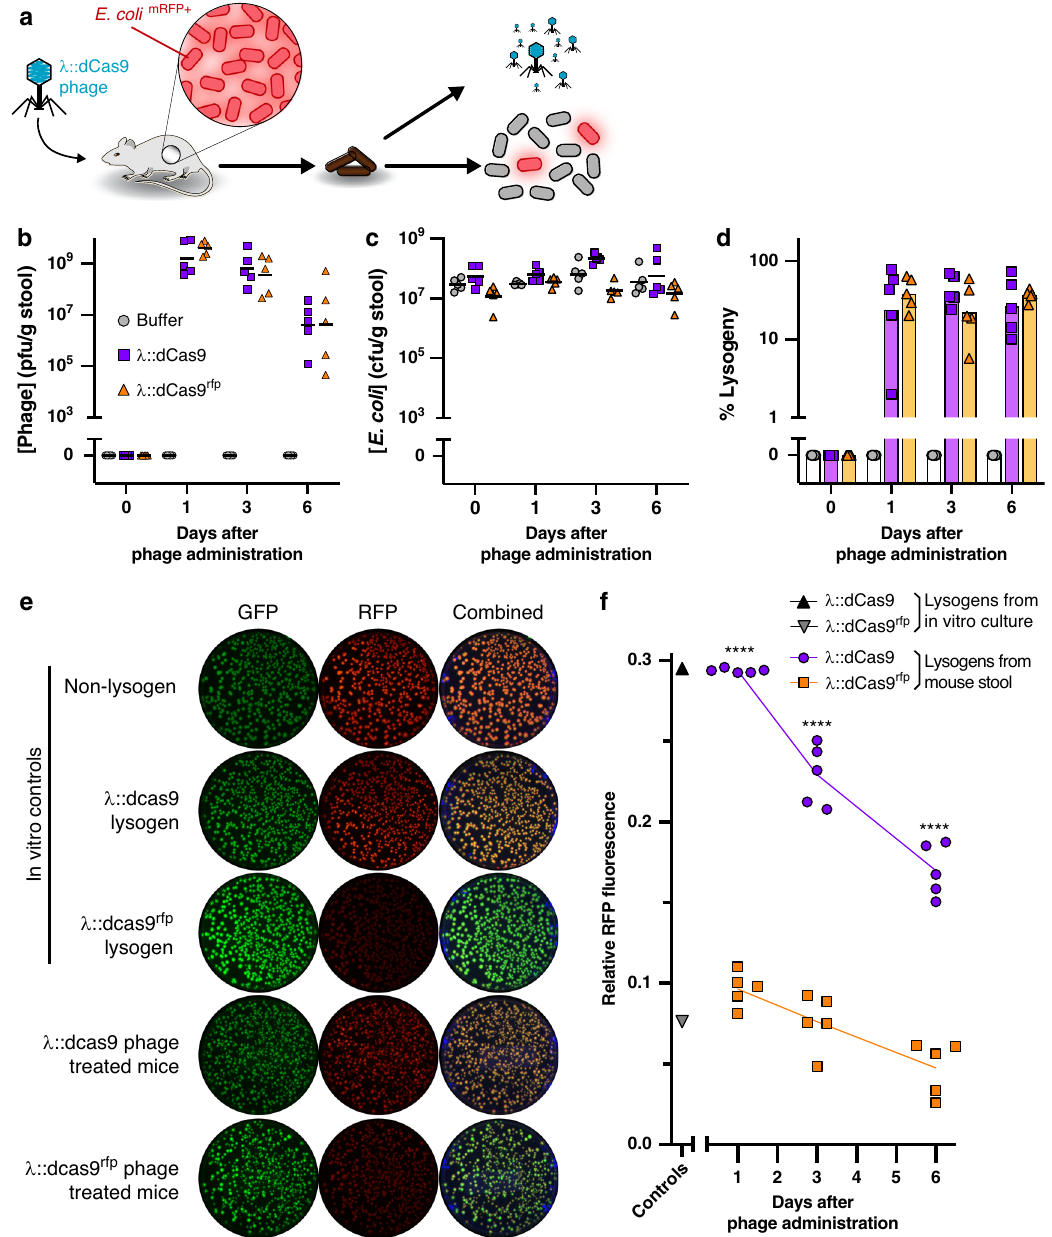
Fig. 3 Phage delivered genetic repression in vivo. Engineered phage or vehicle was orally administered in bicarbonate solution to mice pre-colonized with E. coli expressing RFP and GFP ( a ). After oral administration, fecal phage ( b ), total E. coli ( c ), and percentage of E. coli lysogenized by phage were quanti fi ed ( d ). Representative fl uorescence images of colonies of fecal lysogens are shown compared to in vitro-cultured controls, reproducible across three time points for each of fi ve mice ( e ). Relative RFP intensity normalized by GFP intensity of fecal lysogens from mice. Positive and negative controls represent in vitro-cultured λ ::dCas9 rfp and λ ::dCas9 lysogens, respectively ( f ). Symbols represent individual mice ( n = 5) with bars or lines indicating the geometric mean. Signi fi cance was calculated for preselected time-matched samples using one-way ANOVA with a Sidak post hoc test (**** P < 0.0001). Source data are provided as a Source Data fi